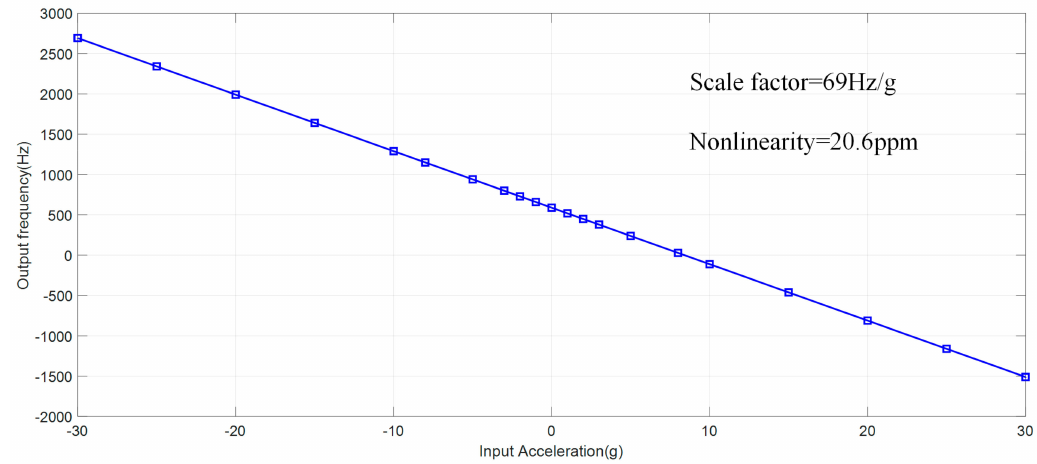
Figure 10. Acceleration response of SOA within a full scale of ± 30 g.